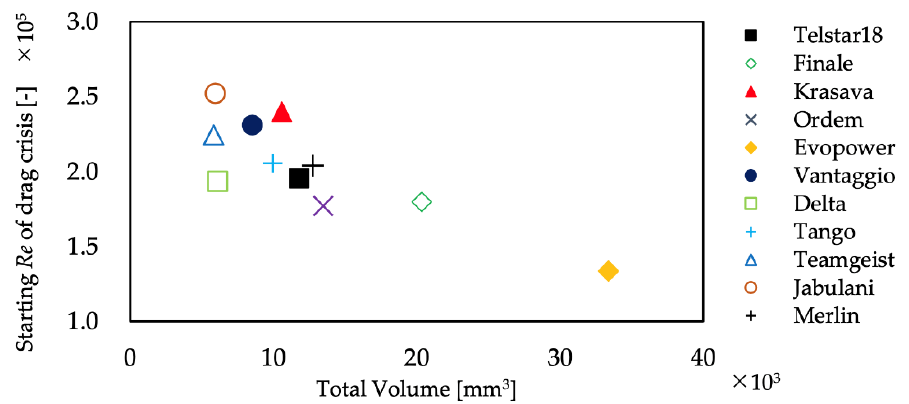
Figure 9. The relationship between the Starting Reynolds number ( Re ) of drag crisis and total groove volume.